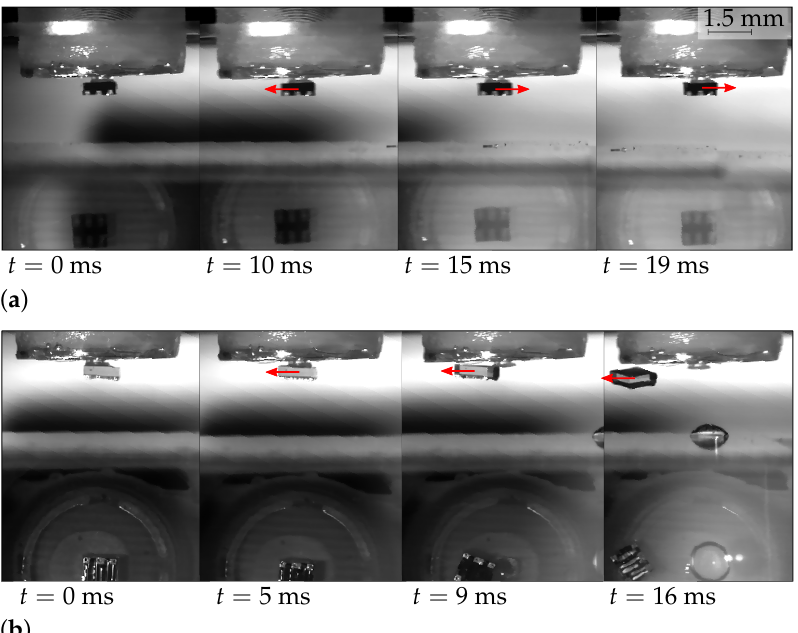
Figure 7. Successive frames of the transportation tests (acceleration and deceleration peaks: 44 m · s − 2 ). The arrows depict inertia. ( a ) The passive gripper is used as intended, so that friction occurs between the component and the picking head when the pressure of the vertical positioning actuator is relieved. In this case, the component remains attached to the gripper and shows no motion relatively to the latter; ( b ) In order to mimic a standard passive capillary gripper where a thin layer of liquid is present at all times to self-align the component, a constant pressure is kept on the cavity. The presence of the liquid layer limits the handling